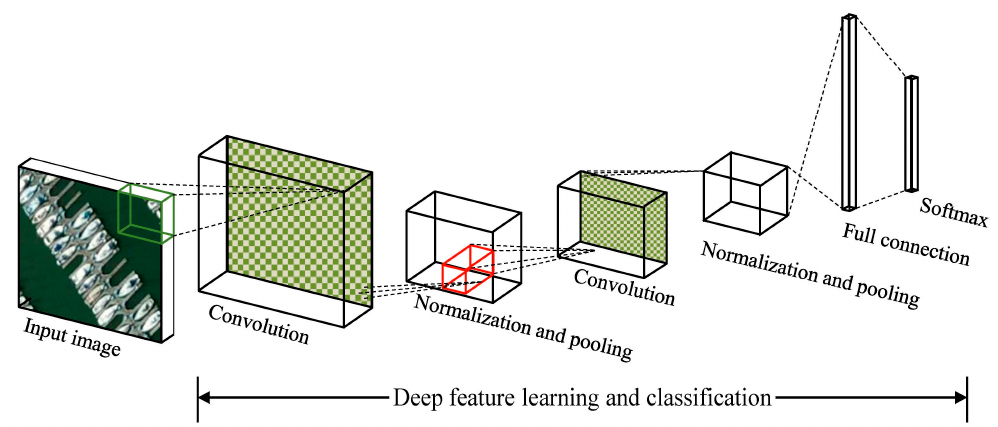
Figure 2. Typical architecture of a convolutional neural network (CNN) for scene classification. The input image gets feature representation through deep networks (pre-trained CNN, unsupervised deep feature learning, and an end-to-end architecture can be included).